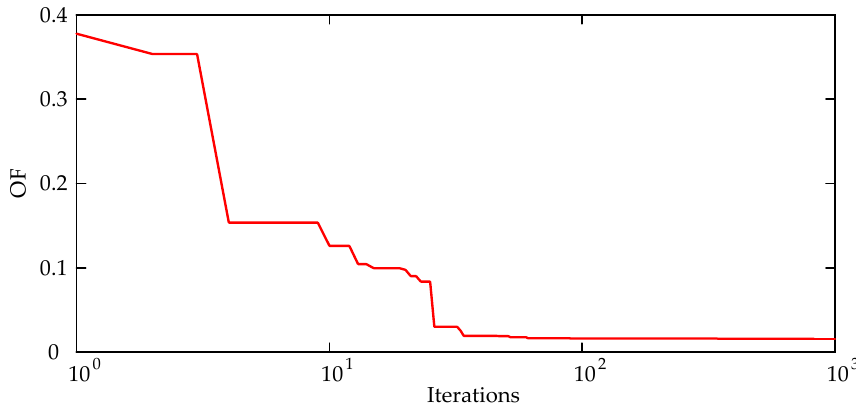
Figure 10. Convergence characteristic of the proposed ImCSA for parameter estimation of the PMM of polycrystalline STP6-120/36 panel.